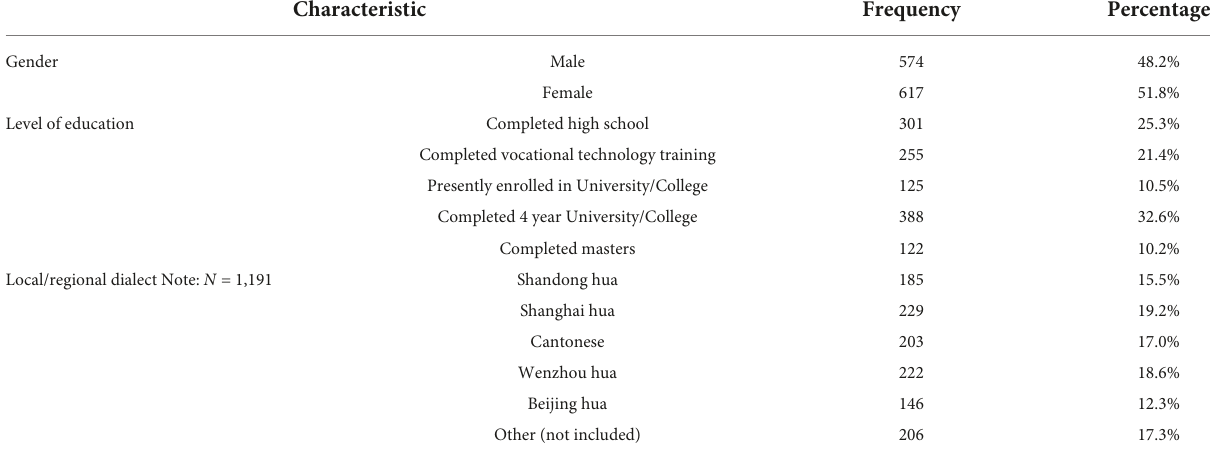
TABLE 1 Demographics of the